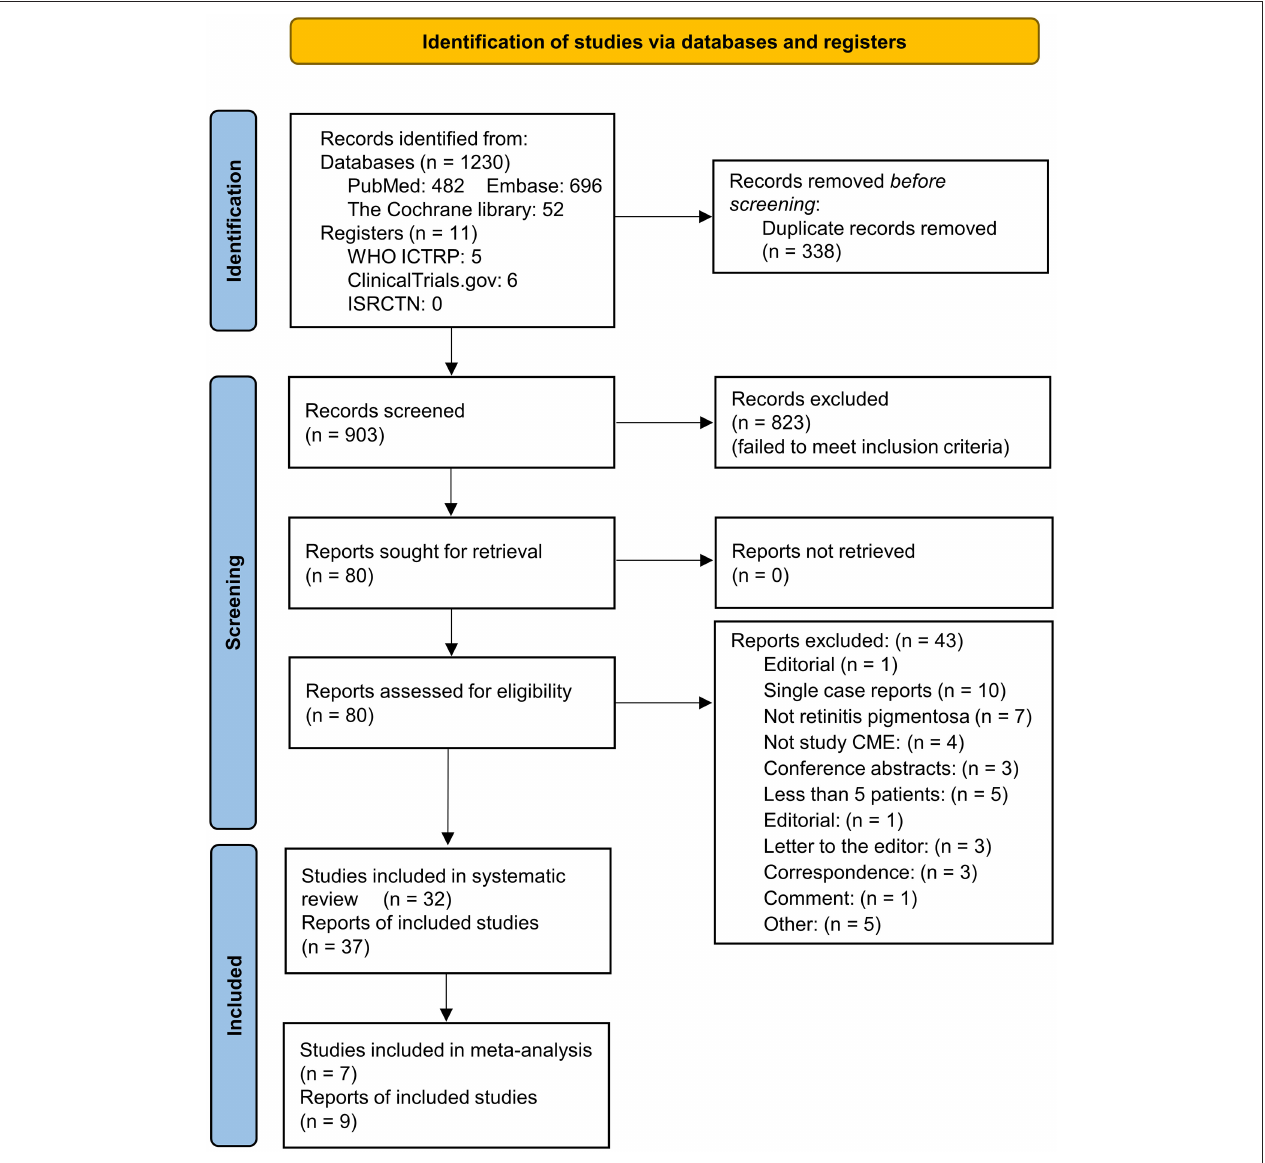
FIGURE 1 | Flow diagram of literature search and records